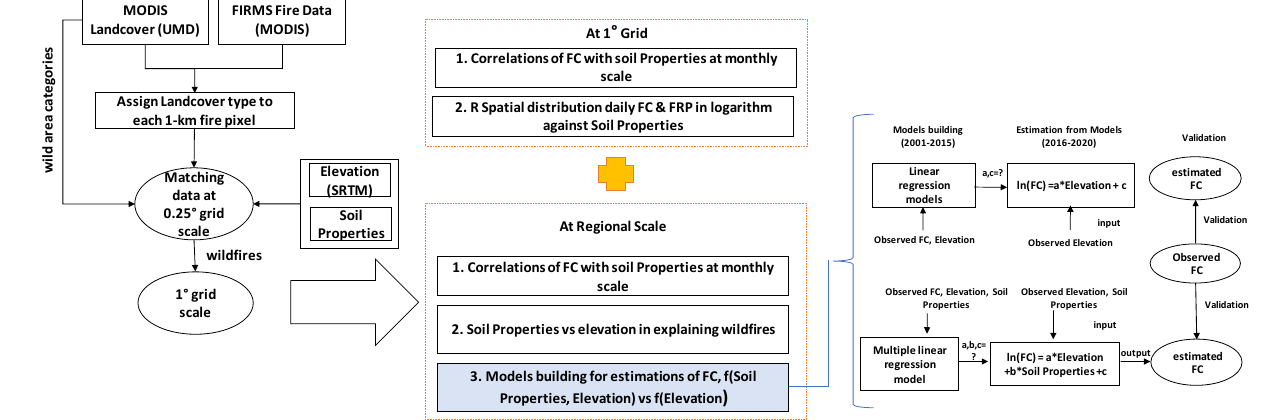
Figure 4. Data processing and approaches used in the study.